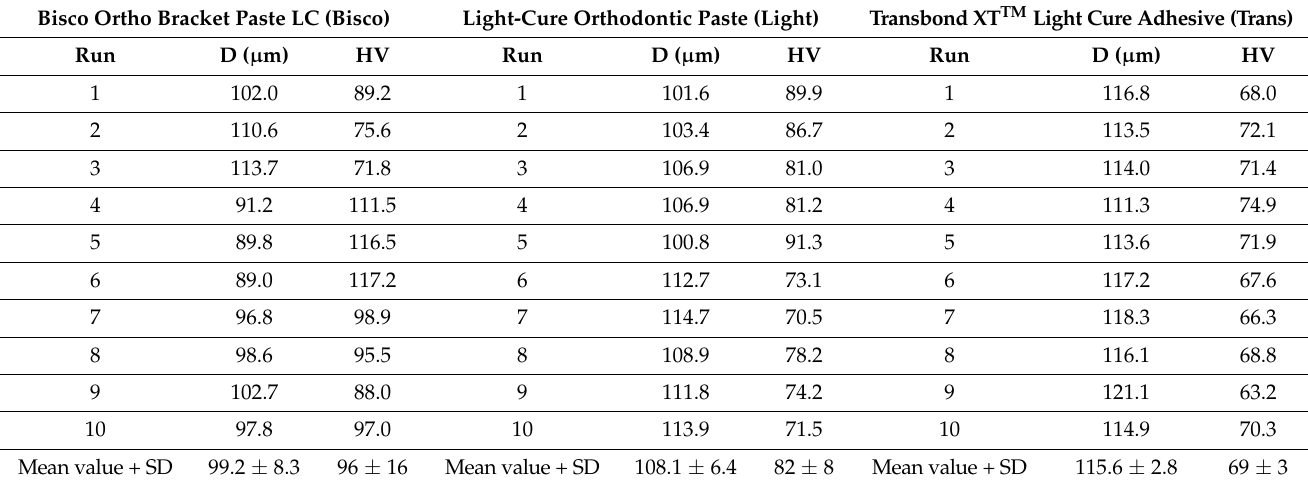
Figure 4. Cross-sectional analysis: SEM images collected on the sidewalls of the FIB milled areas on ( a ) the Bisco Ortho Bracket Paste LC (Bisco), ( b ) Light-Cure Orthodontic Paste (Leone), and ( c ) Transbond XT TM Light Cure Adhesive (Trans) after FIB milling. The images have been collected at a magnification of 60,000 via in-lens detector. The scale bars indicate 500 nm. Table 2. Set of experimental diagonal lengths and calculated HV values obtained for applied load of 500